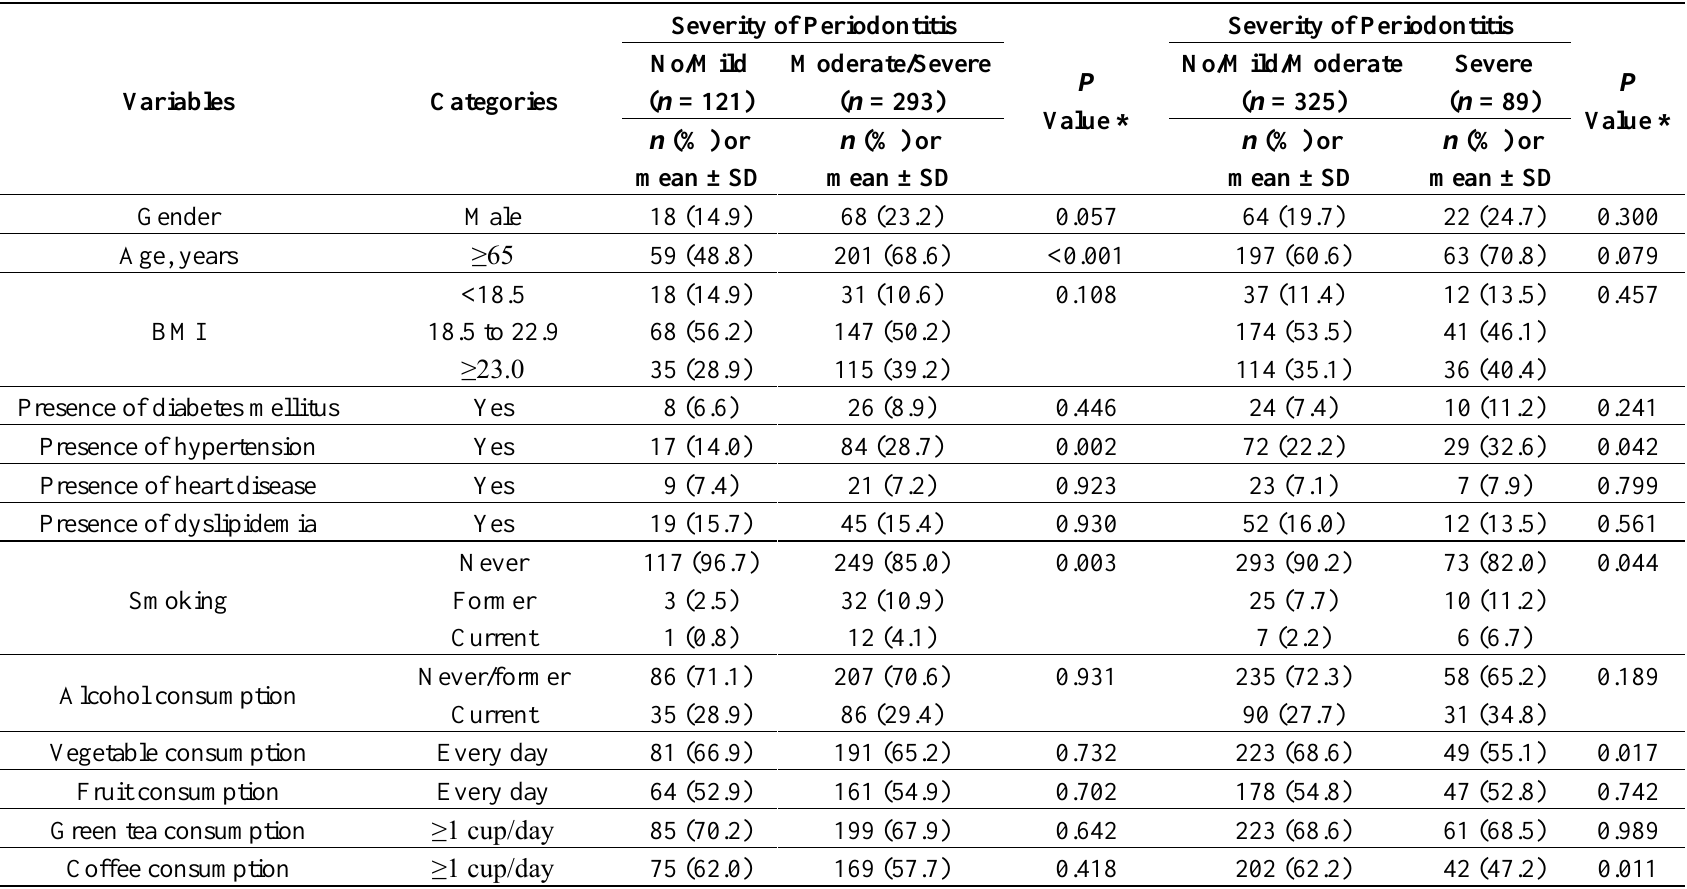
Table 2. Comparisons of the variables of the participants with severity of